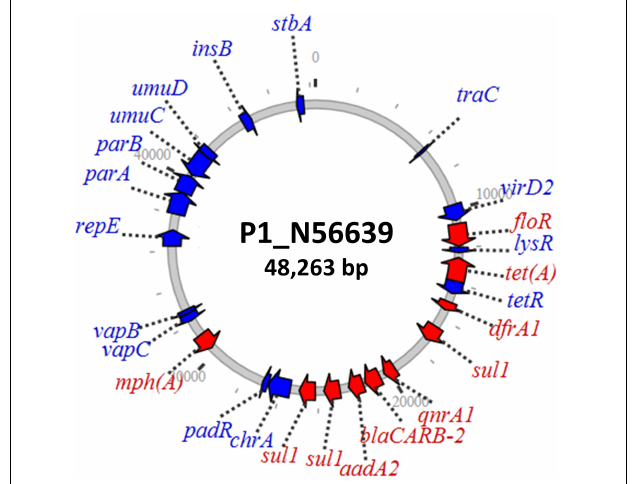
FIGURE 2 | IncR plasmid containing qnrA1 with various additional resistance